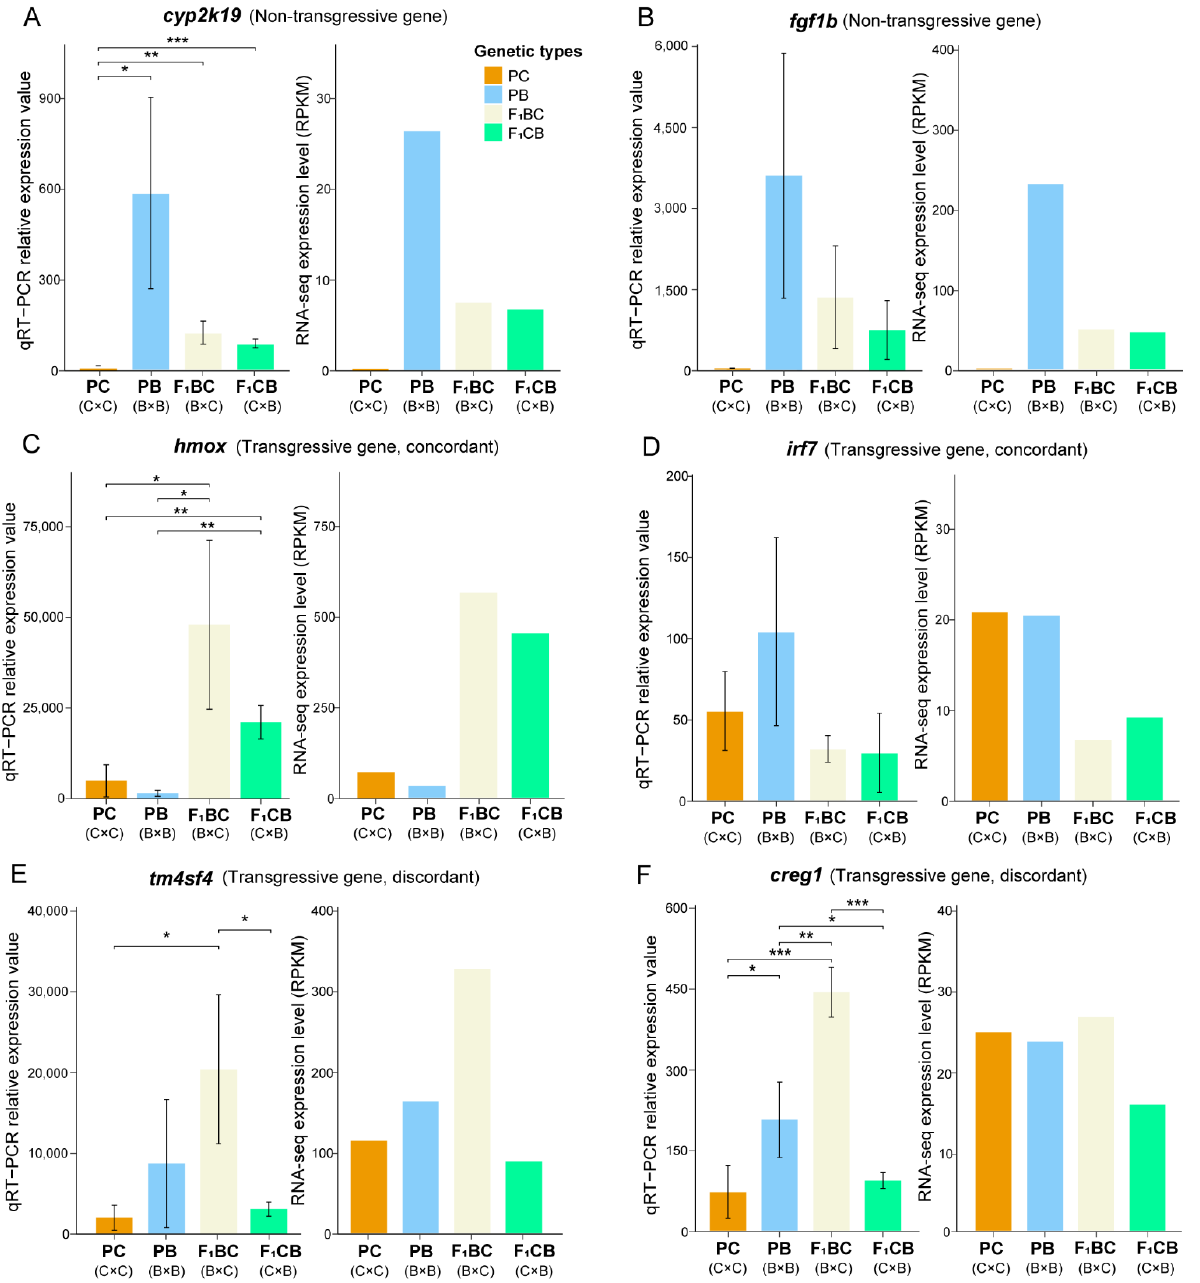
Figure 6. Quantitative reverse transcription PCR validation of differentially expressed genes and transgressive genes. PC: channel catfish Ictalurus punctatus parental cross; PB: blue catfish I. furcatus parental cross; F 1 BC: blue catfish female × channel catfish male hybrids; F 1 CB: channel catfish female × blue catfish male hybrids. Barplots of qRT ‐ PCR relative quantification and RNA ‐ seq RPKM values (Reads Per Kilobase of transcript per Million mapped reads) for non ‐ transgressive genes cyp2k1 ( A ) and fgf1 ( B ), concordant transgressive genes hmox ( C ) and irf7 ( D ), and discordant transgressive genes tm4sf4 ( E ) and creg1 ( F ). Mann–Whitney U test was used to assess the statistical significance (*, p < 0.05; **, p < 0.01; ***, p < 0.001).